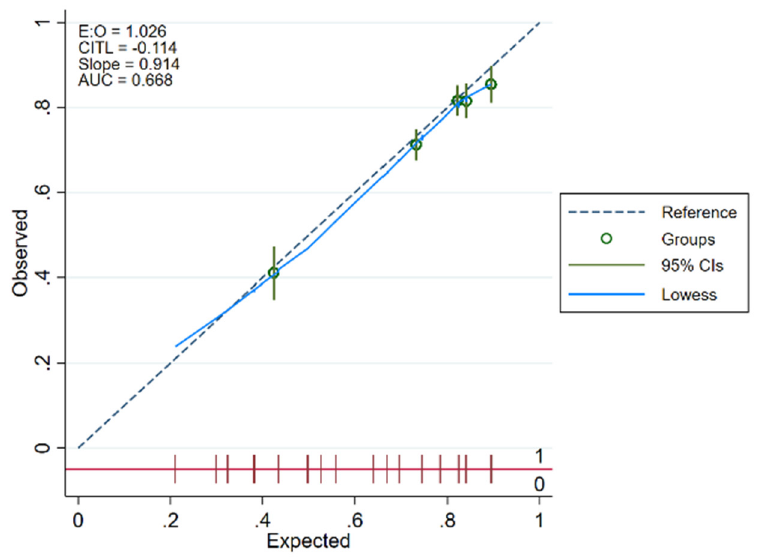
Figure 3. Calibration plot for Cardiac Arrest Cardio-Oncology Score (CACOS) for the derivation sub-sample.